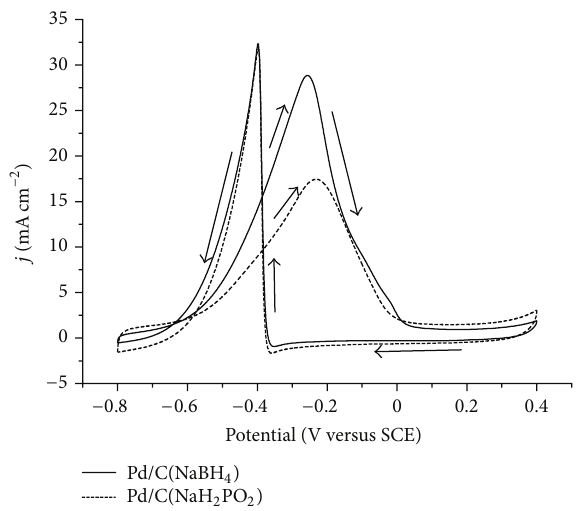
Figure 3: Voltammetric curves of Pd/C (NaBH 4 ) and Pd/C